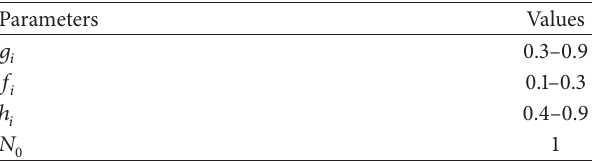
Table 1: Parameter